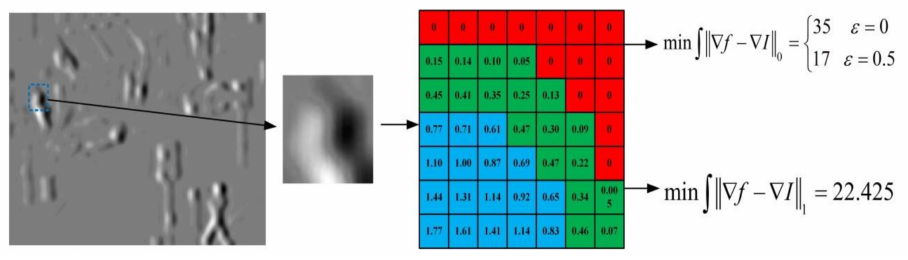
Figure 1. The illustration of two type of